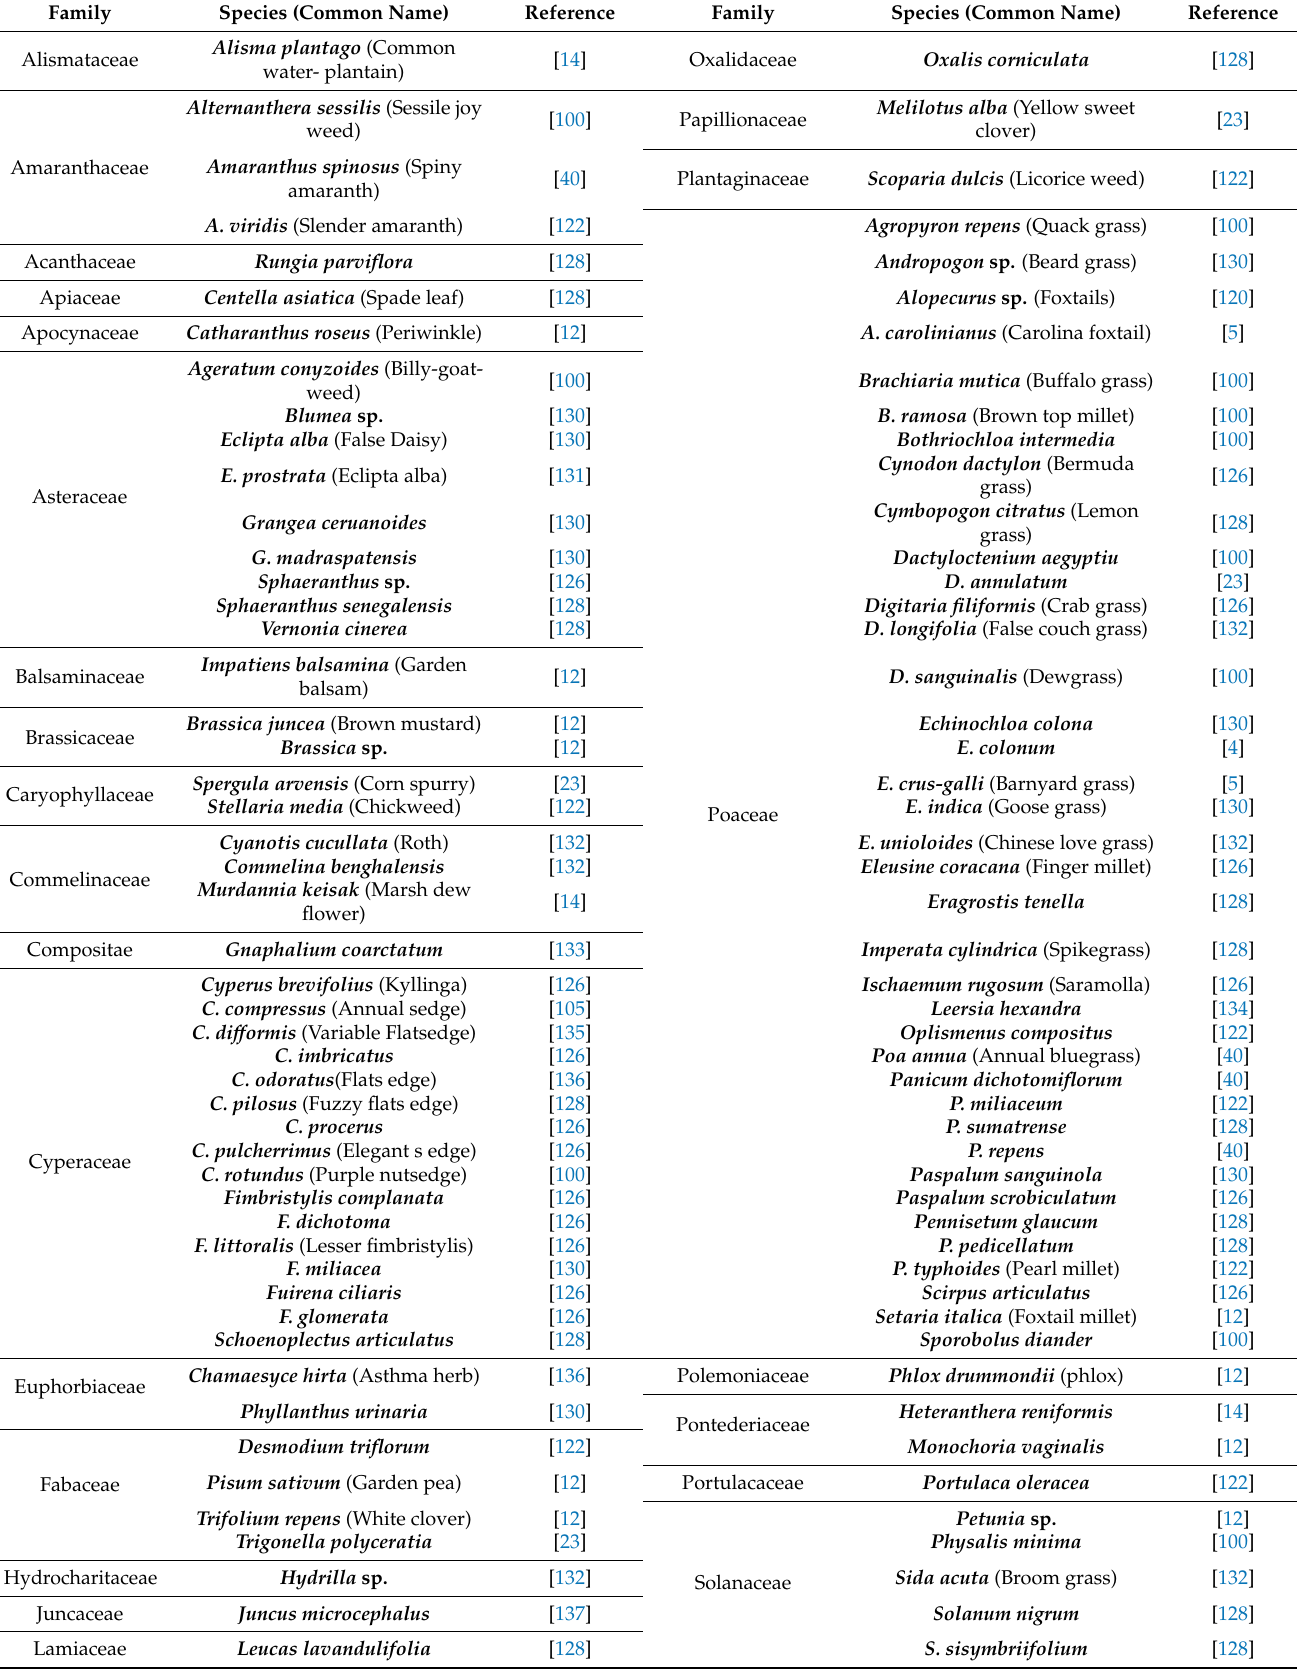
Table 3. Weeds hosts of Meloidogyne